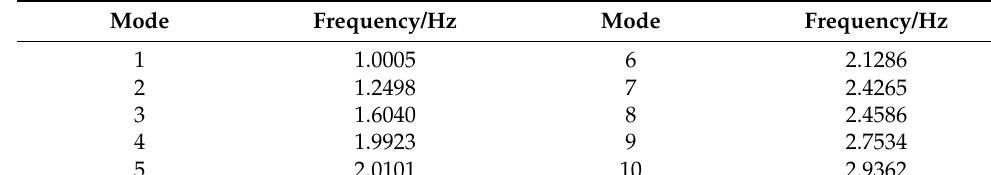
Table 2. Modal frequencies of the membrane antenna.